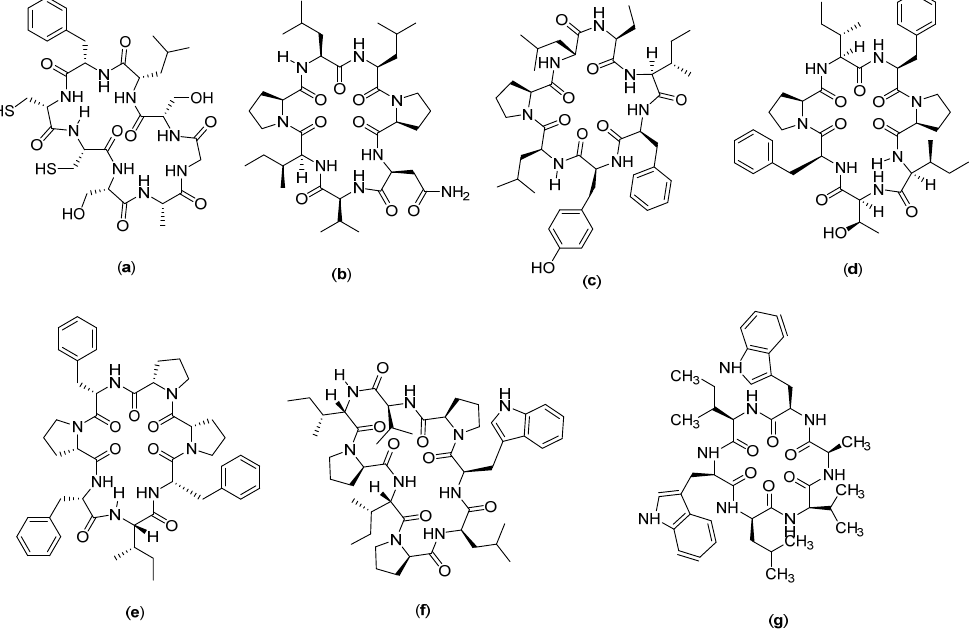
Figure 11. Structure of: ( a ) ALOS4; ( b ) Reniochalistatin A; ( c ) Reniochalistatin B; ( d ) Reniochalistatin C; ( e ) Reniochalistatin D; ( f ) Reniochalistatin E; and ( g ) Nocardiotide A. Reniochalistatin (Figure 11b–f) is a cyclic peptide compound isolated from the marine sponge Reniochalina stalagmitis obtained from Yongxing Island in the South China Sea.